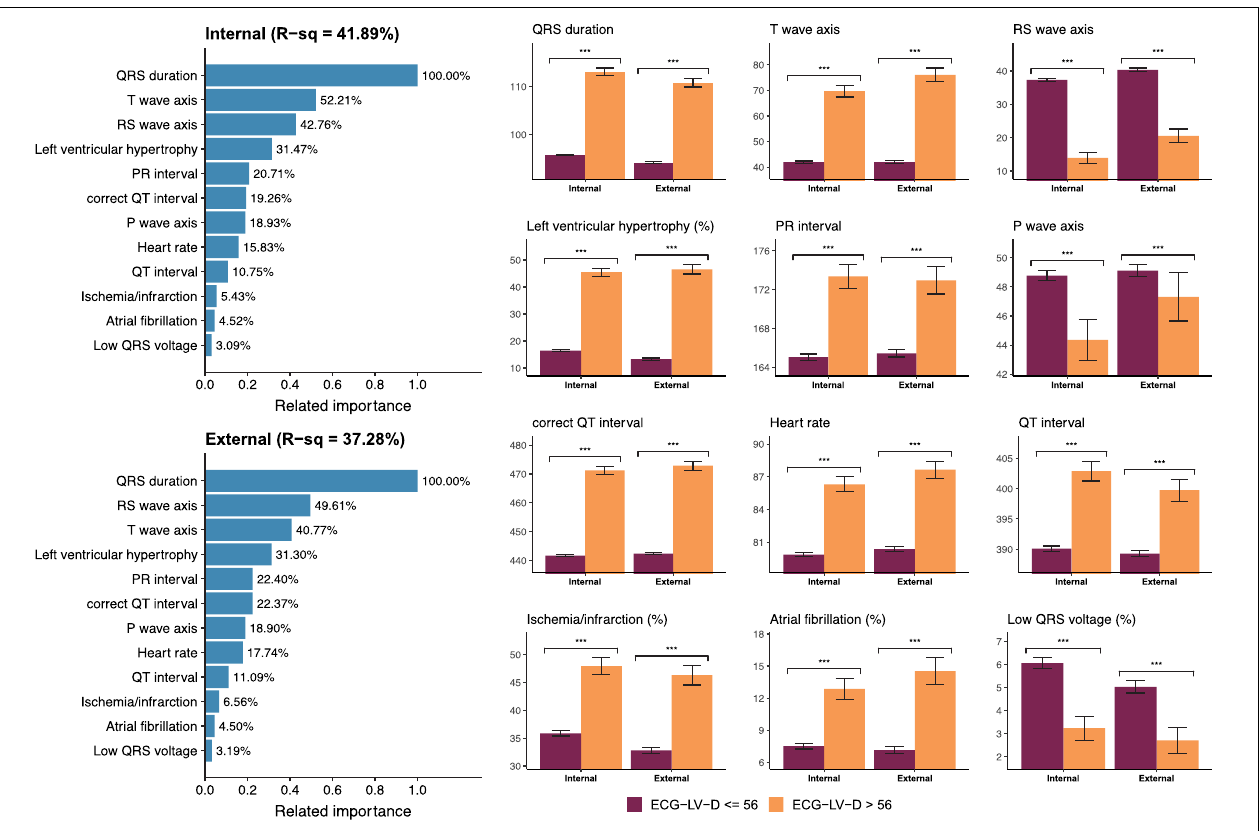
FIGURE 6 | Relationship between most important ECG features and ECG estimated left ventricle (end-diastole) (ECG-LV-D). The related importance is based on the information gain of eXtreme gradient boosting (XGB) model, and the R-square (R-sq) is the coefficient of determination to use selected ECG features for predicting ECG-LV-D. The AI-ECG predictions were classified as ECG-normal (ECG-LV-D ≤ 56) and ECG-abnormal (ECG-LV-D > 56). The analyses are conducted both in internal and external validation sets (*** p <